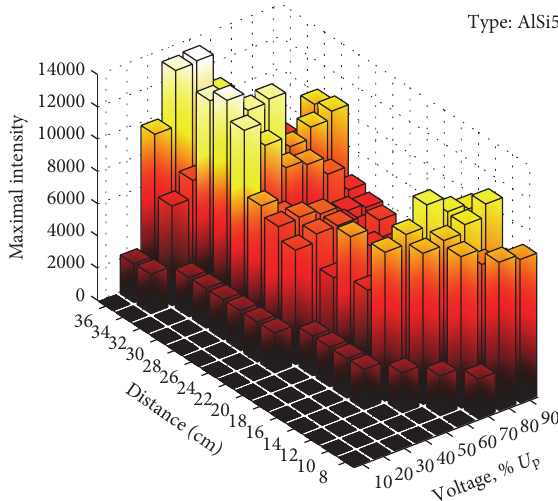
Figure 18: Dependency of voltage and distance on the highest intensity value for the MIG308LSi line.